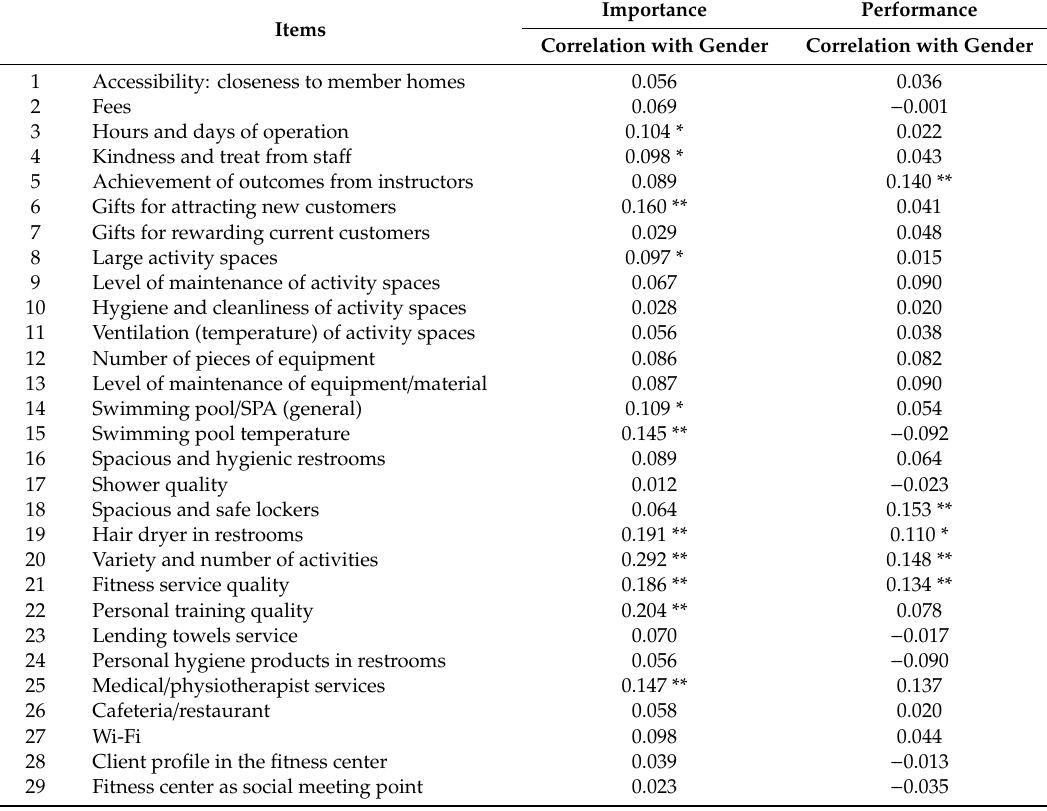
Table 3. Gender correlation with importance and performance scores.